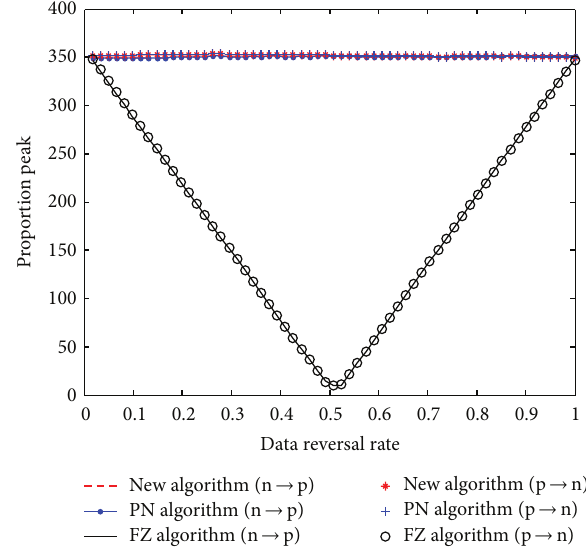
Figure 4: The relationship of the synchronization proportion peak and the SNR.